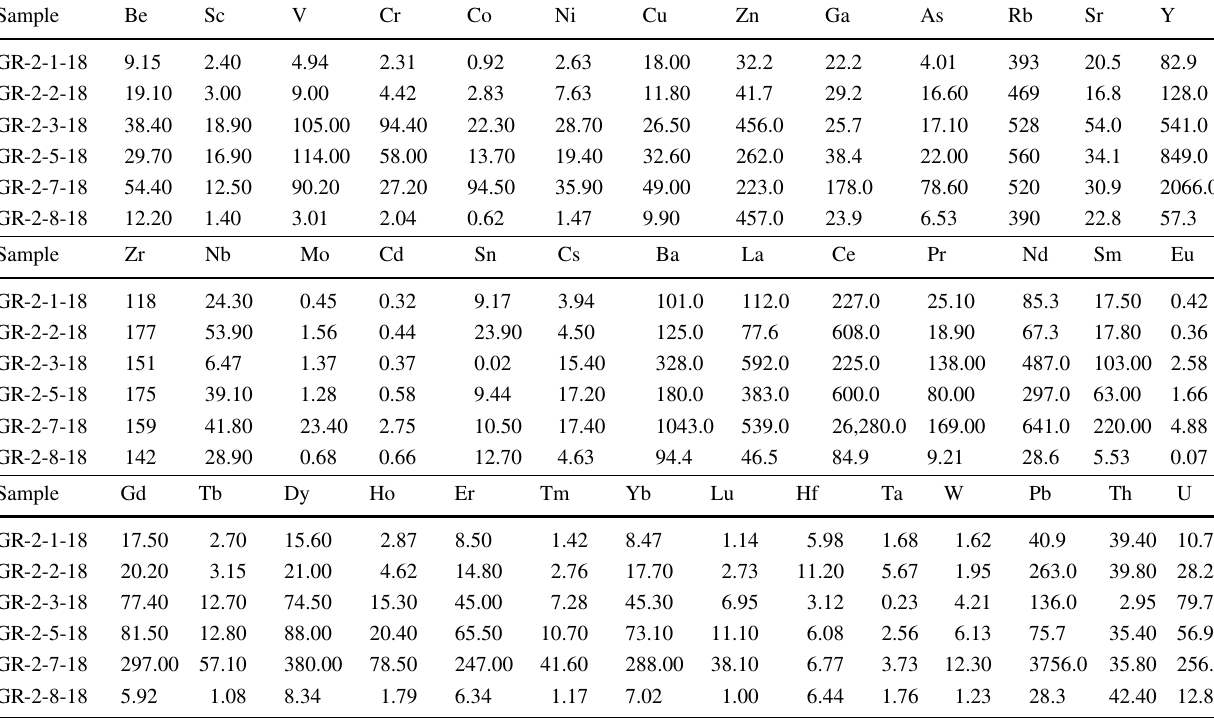
Table 3 Concentration of rare elements (g/t) in altered granites (GR-2-1-18, GR-2-2-2-18, GR-2-8-18), dike (GR-2-3-18, GR-2-5-18), and ore crust (GR-2-7)-18 from the depression flanks (analyzed by atomic emission spectrometry) Sample